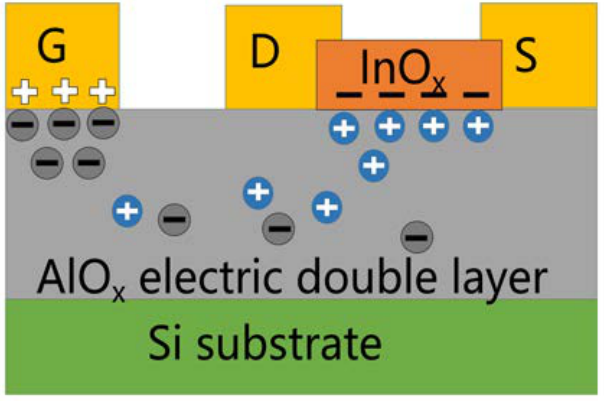
Figure 4. Lateral coupling effect in AlO x /InO x EDLT with planar gate.